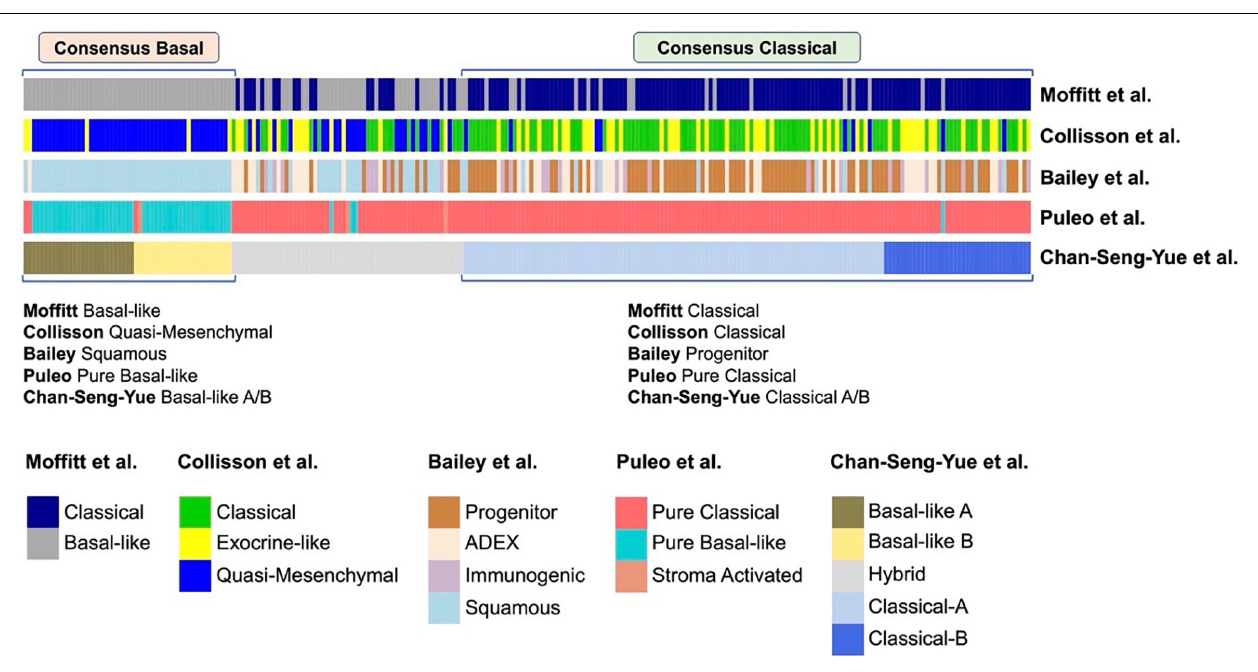
Frontiers in Cell and Developmental Biology |